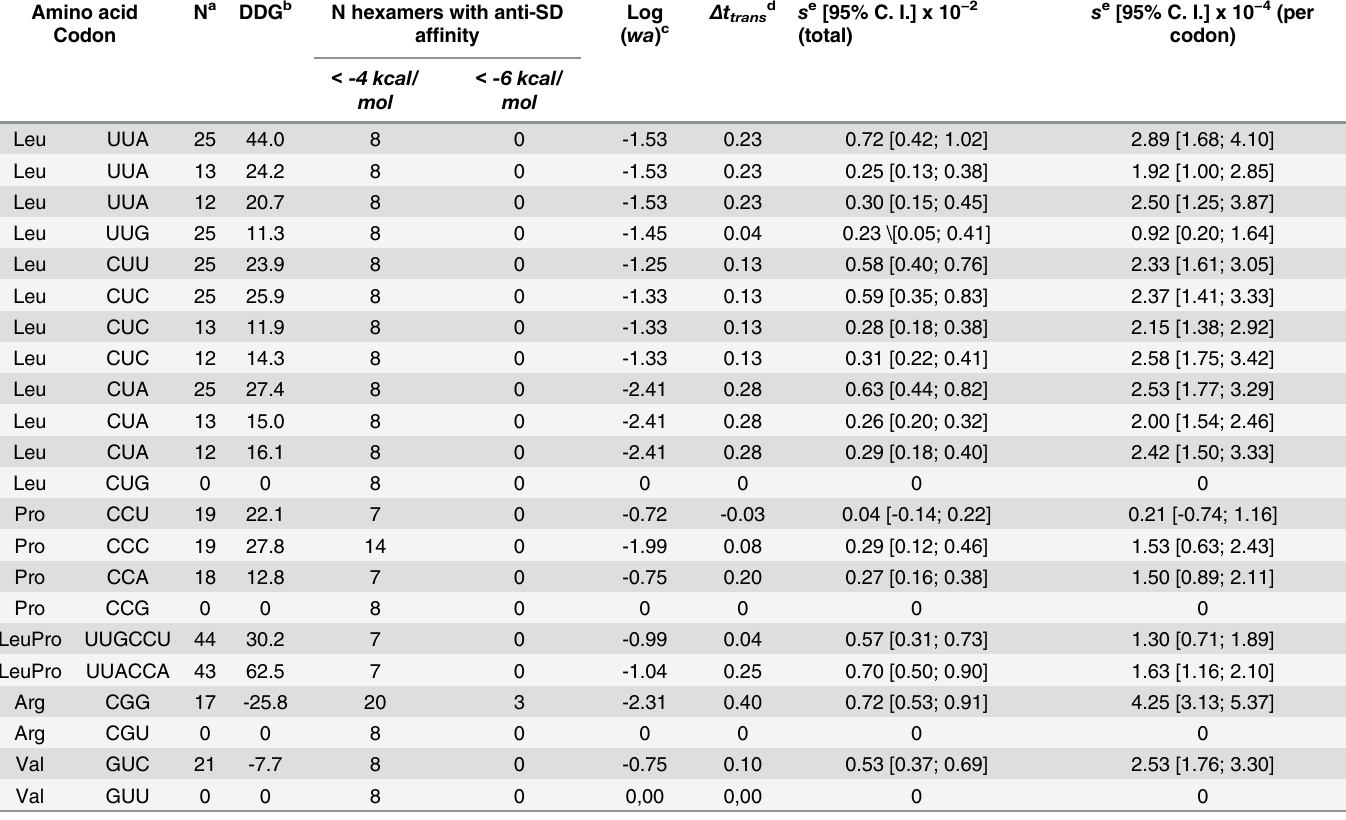
Table 1. The selective disadvantage of synonymous tuf